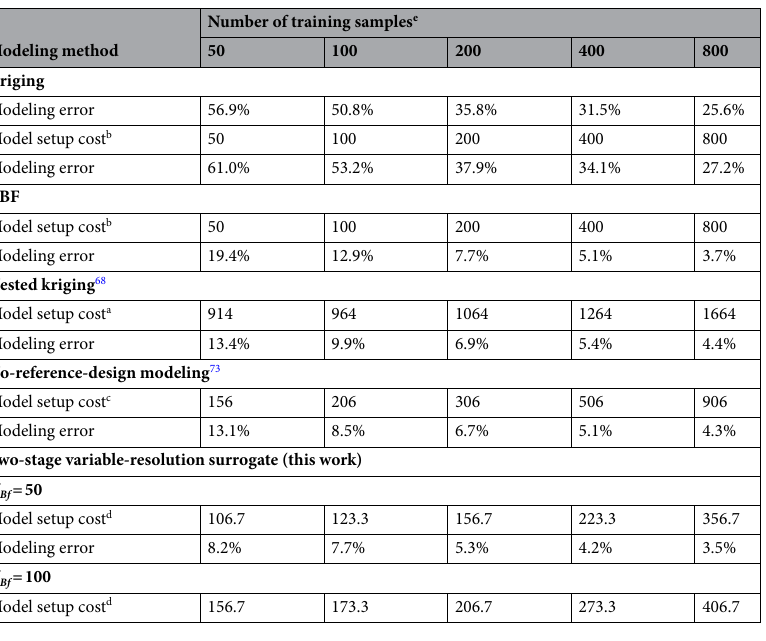
Table 3. Antenna I: modeling results and benchmarking. a The cost includes acquisition of the reference designs, which is 864 EM high-fidelity simulations of the antenna when using feature-based optimization 67 as listed in the table. Conventional (minimax) optimization required high-fidelity 1012 simulations. b The cost refers to high-fidelity simulations. c The cost includes generation of random trial points, here, 106 high-fidelity simulations in total to yield N r = 50 accepted samples. d The cost includes generation of random trial points at low-fidelity level, here, 120 simulations in total to yield N r = 50 accepted samples. e In the case of the proposed model, the numbers 50 through 800 refer to low-fidelity EM